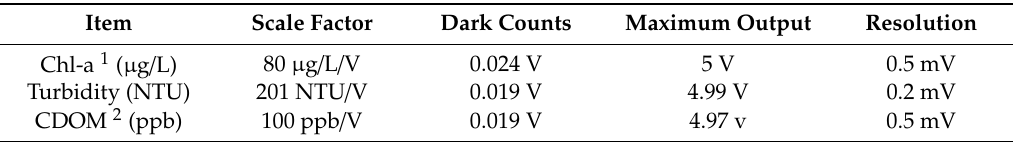
Table 1. The calibration coe ffi cients and characterization of ECO (Environmental Characterization Optics) fluorometers.